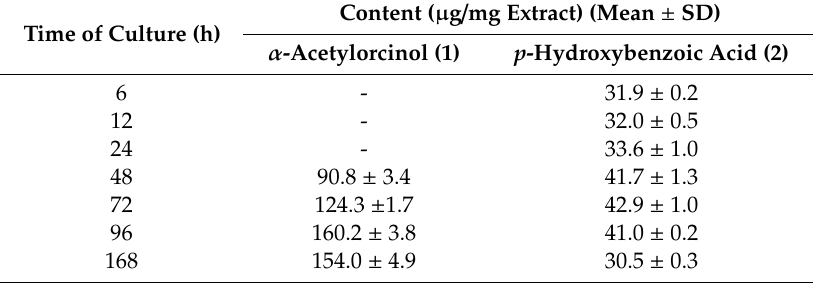
Table 1. Quantification of phytotoxins 1 and 2 in organic extracts from cultures of A. dauci kept at di ff erent times of